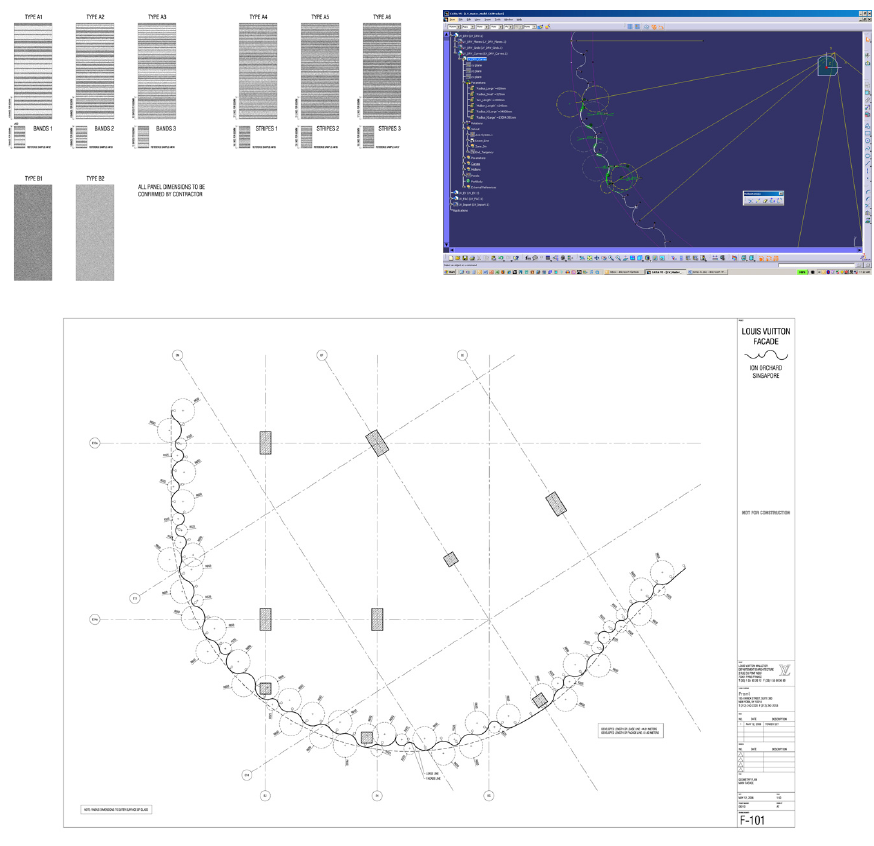
Figure 19a, b, c: Glass Texture Families, CATIA Tool for Geometry Management, General Arrangement Plan. The glass itself is laminated annealed glass with 2 sheets of 8mm low-iron material. Each individual pair of panels is heat slump-textured in a sand-bed by Fusion Glass, London. The deformation is sufficiently significant that mating pairs of glass are required to be slumped simultaneously so that the geometrical offset between the two surfaces would be consistent for resin laminating. Subsequent to the slumping process that imparts one of six custom line textures, the panels are then, again as a mating pair, heat curved into “C” shapes, “S” shapes and double “S” shapes. Each segment of curvature along the façade is unique however the developed length of every panel is precisely 990mm and has only one of the six specified textures. However, in the end, each panel address is a unique combination of geometry and texture specification allowing for no repetition in the final